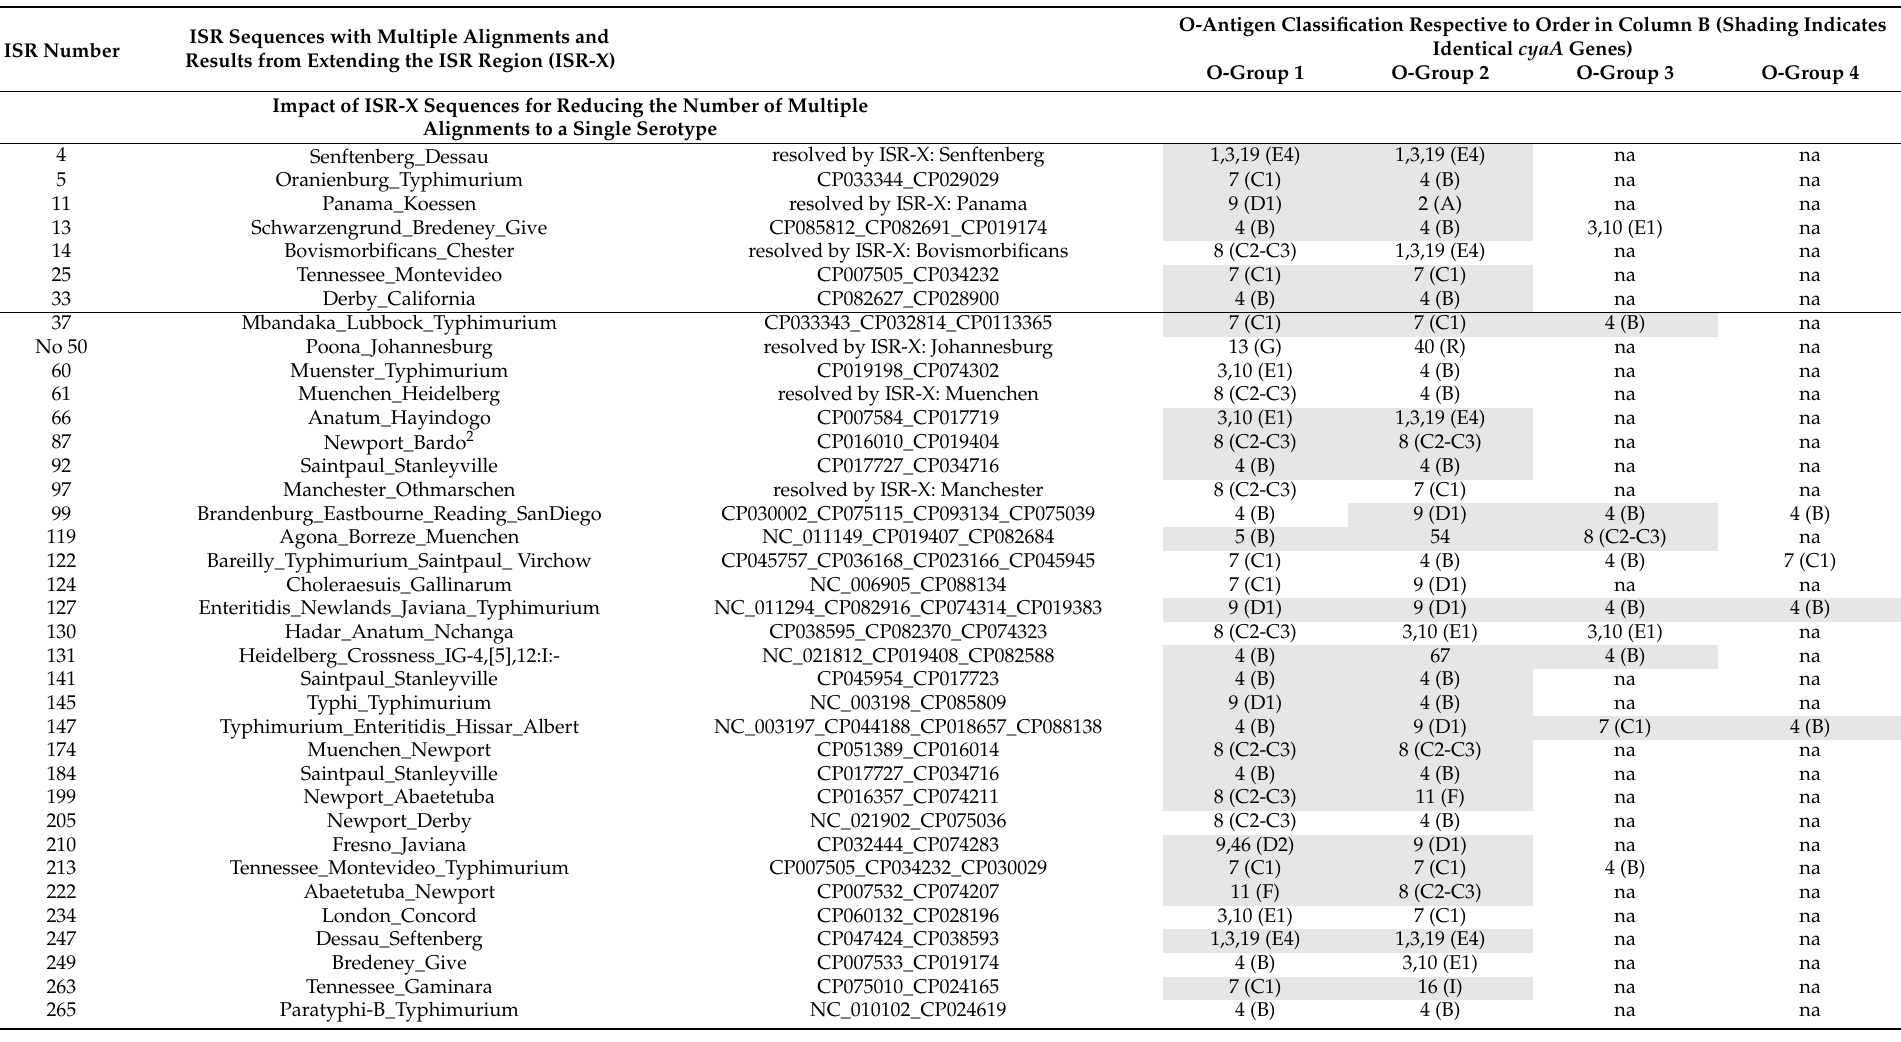
Table 2. Association between the ISR, adenylate cyclase (cyaA) sequences, and O-antigen classification for serotypes of Salmonella enterica subspecies I that had multiple